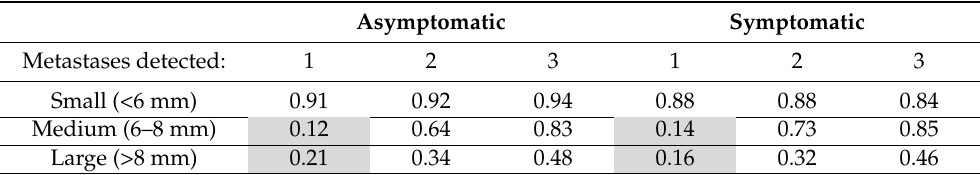
Table A15. Proportion of oligo+ within patients with detected oligo-metastases in the Metastatic metastases 20% scenario.